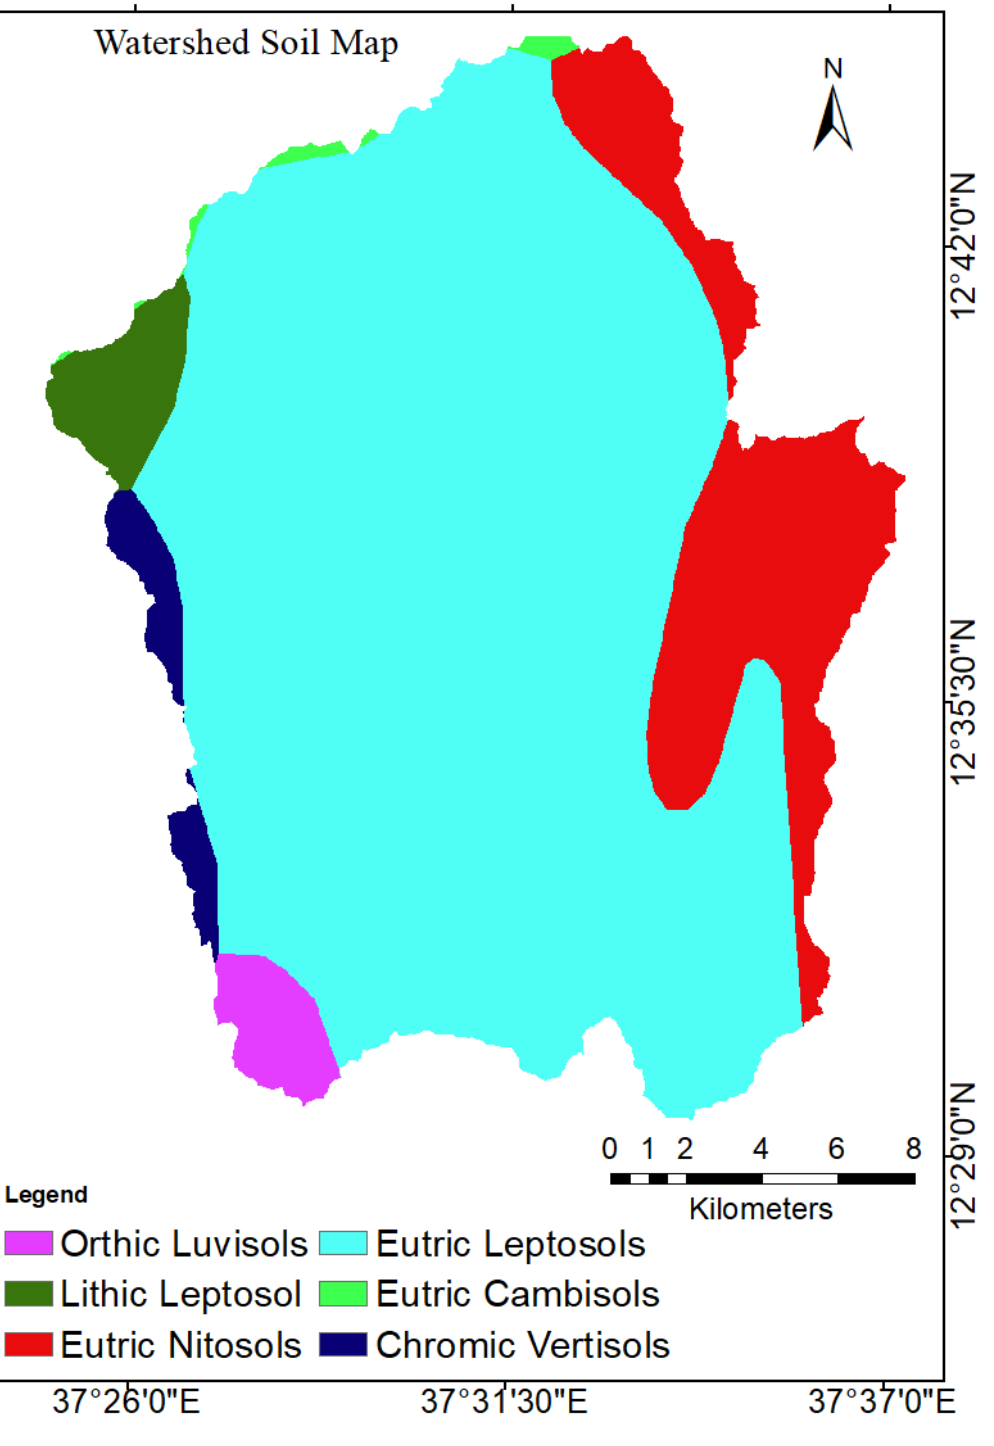
Figure 4. Soil map.